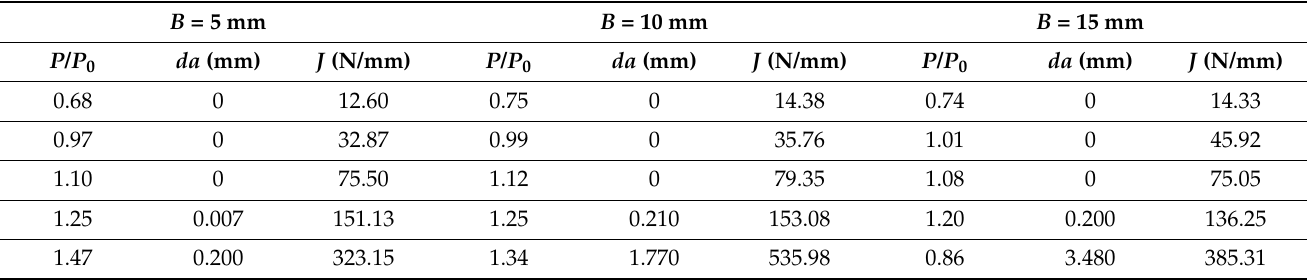
Table 2. Values of the J -integral, increments of crack length, for selected moments in the range of the entire load of SEN(B) specimens for 41Cr4